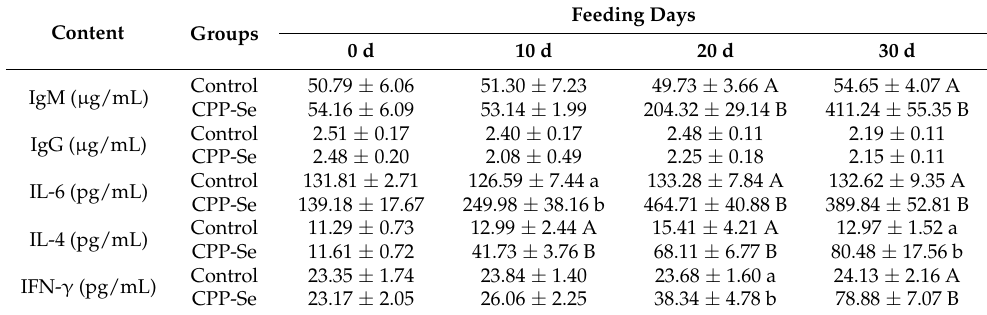
Table 3. Effects of CPP-Se on the levels of serum cytokines and immunoglobulins in